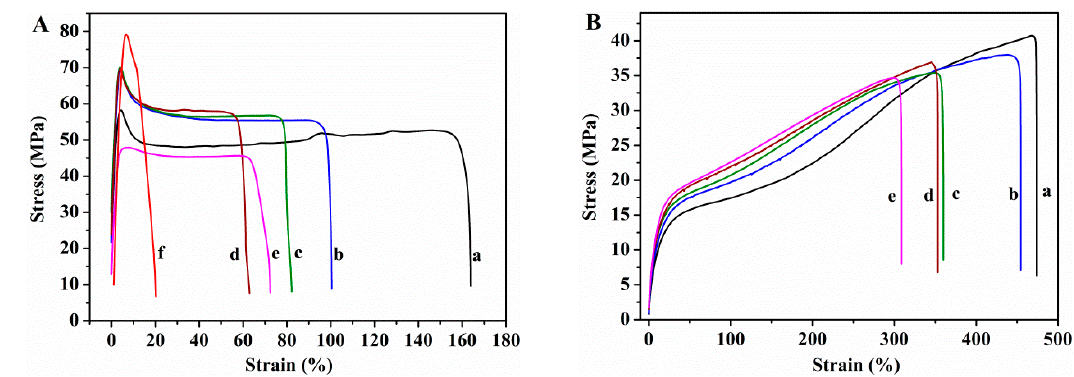
Figure 10. Stress–strain curves of ( A ) unplasticized and ( B ) glycerol plasticized: (a) PVA; (b) PVA/GS0.5; (c) PVA/GS1; (d) PVA/GS1.5; (e) PVA/GS2; and (f) PVA/GS1 ex situ.